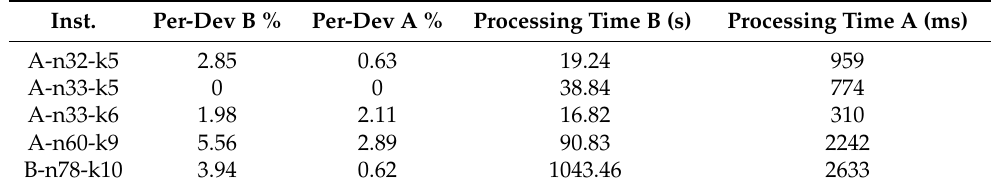
Table 4. The obtained co-simulation result of models M 2 with M 2 . Inst. Per-Dev B %